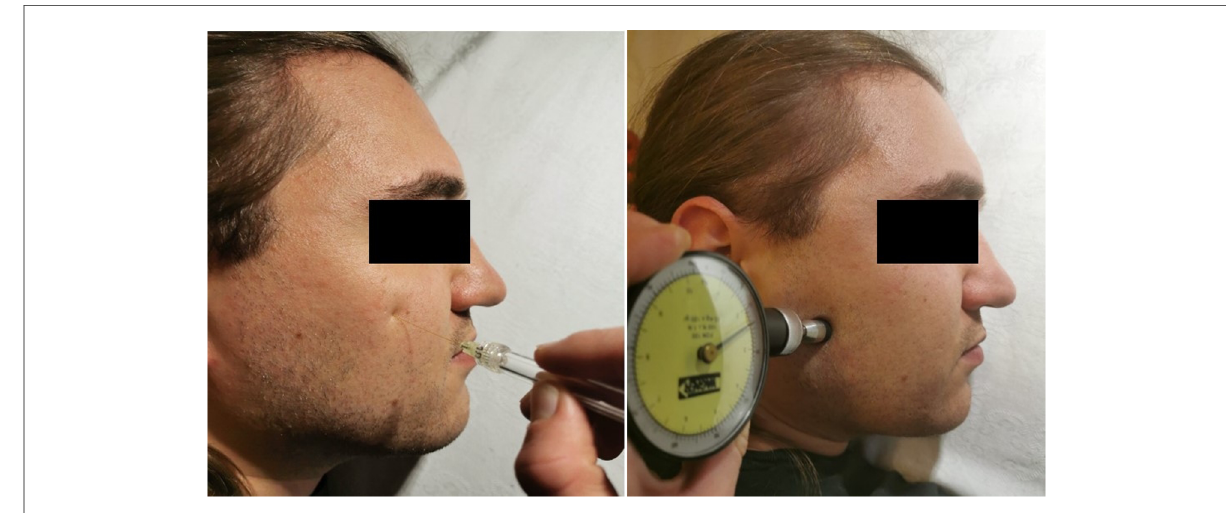
FIGURE 1 Left: Investigation of the mechanical detection threshold (MDT) at a standard spot on the face using von Frey hairs. Right: Investigation of the pressure pain threshold (PPT) using a pressure algometer on the